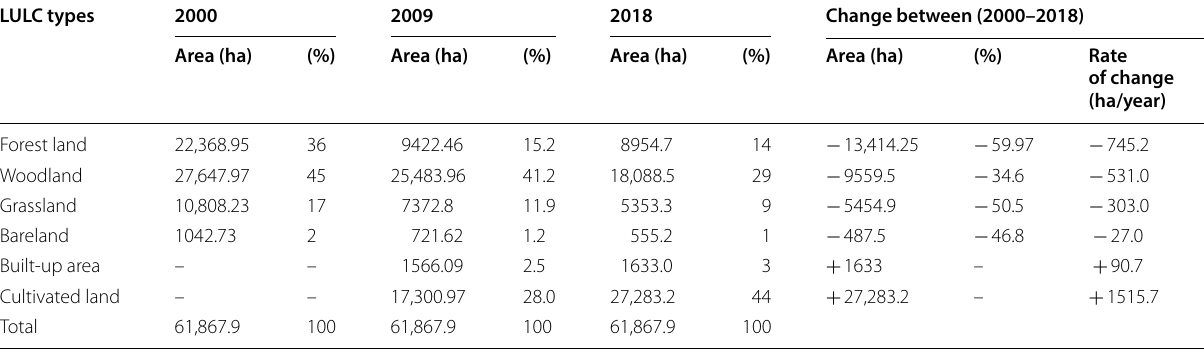
Table 4 Comparison of LULC types between 2000 and 2018. Source: Computed from satellite imageries of 2000,